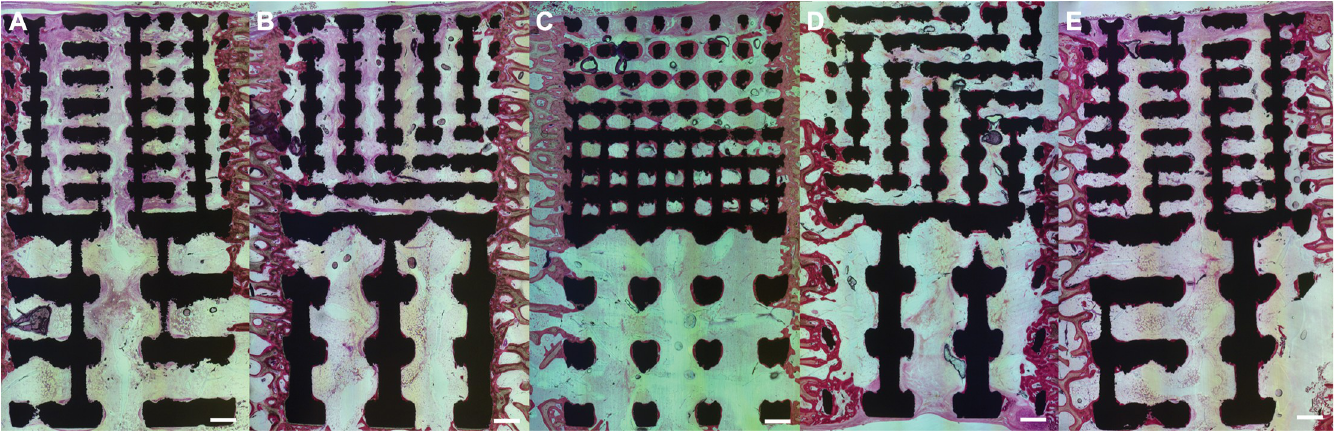
Fig 4. Light microscopy images of histological slices of implants retrieved from ovine femoral condylar defect after 6 weeks: (a) uncoated, (b) plasma sprayed HA, (c) electrochemical HA, (d) electrochemical SiHA and (e) electrochemical SrHA. Toluidine blue and Paragon used to stain bone and soft tissues pink and purple respectively. Black regions correspond to locations of the Ti6Al4V struts. Scale bar indicates 1mm.